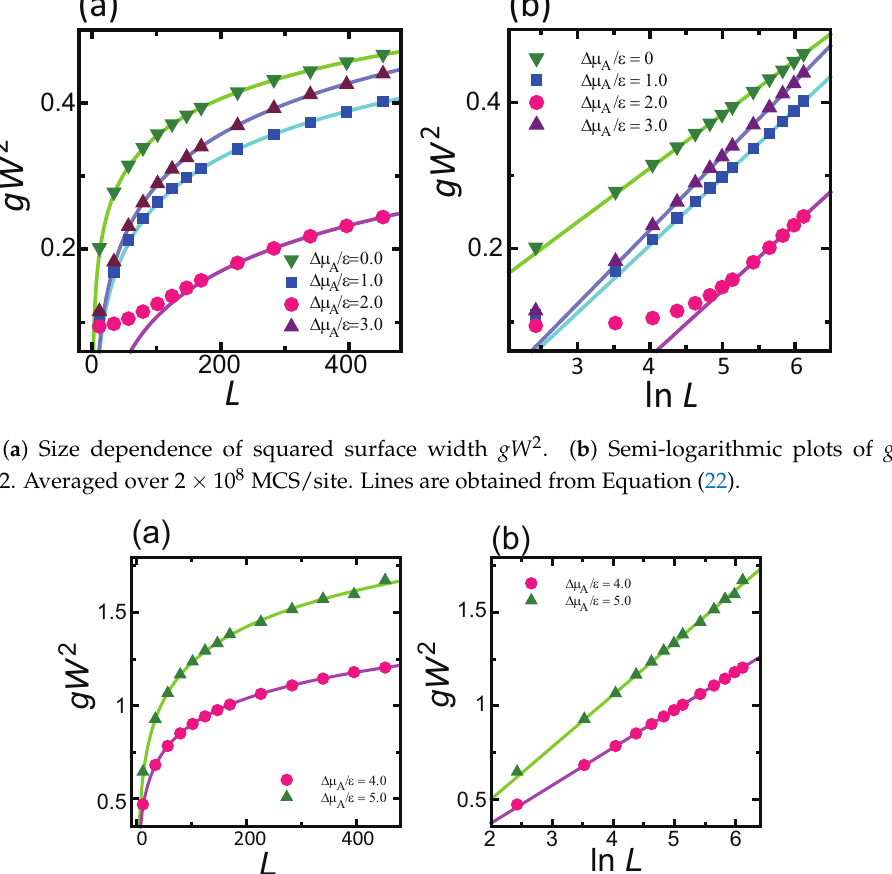
Figure 10. ( a ) Size dependence of squared surface width gW 2 . ∆ µ A is so large that step tension on the ( 001 ) surface is negative. ( b ) Semi-logarithmic plots of gW 2 . k B T / (cid:101) = 0.2. Averaged over 2 × 10 8 MCS/site. Lines are obtained from Equation